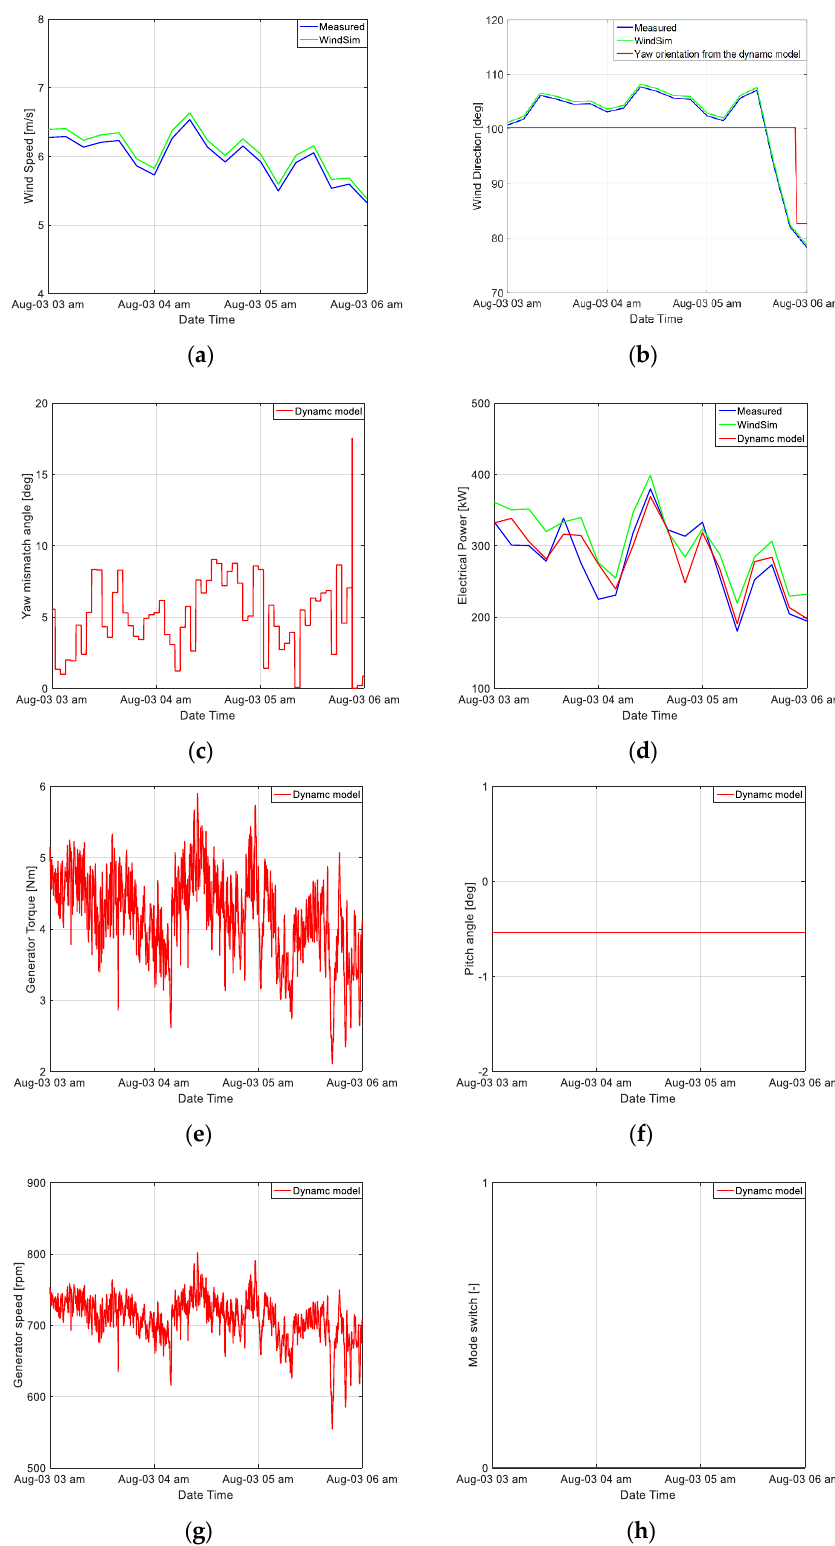
Figure 11. Comparison of the measured and predicted data for 3 h in August: ( a ) wind speed, ( b ) wind direction, ( c ) yaw mismatch, ( d ) electrical power, ( e ) generator torque, ( f ) pitch angle, ( g ) generator speed, ( h ) model switch.